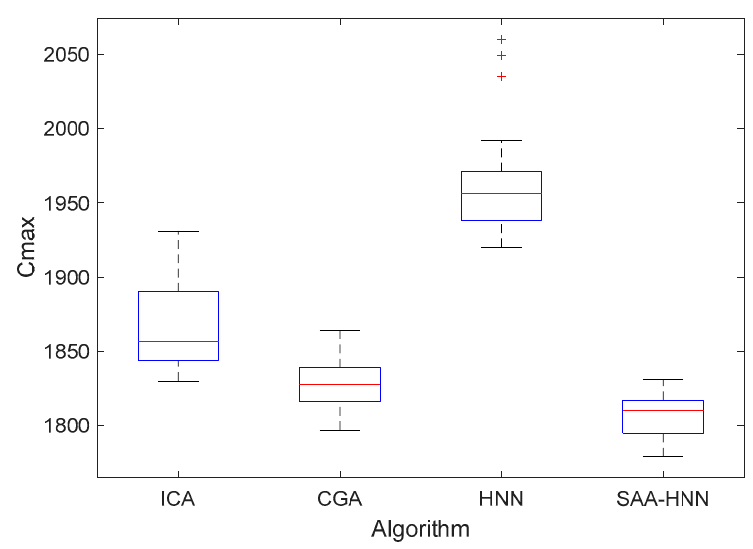
Figure 3. Box-plot of four algorithms for large-scale data j80c8a2.